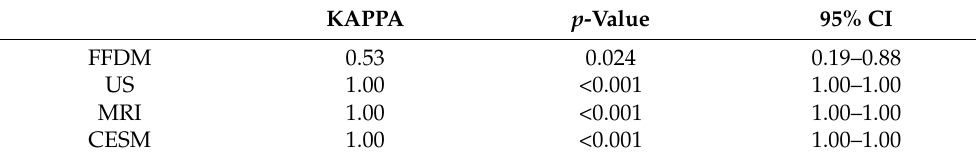
Table 7. Results on the inter-observer agreement calculated on the findings of the two